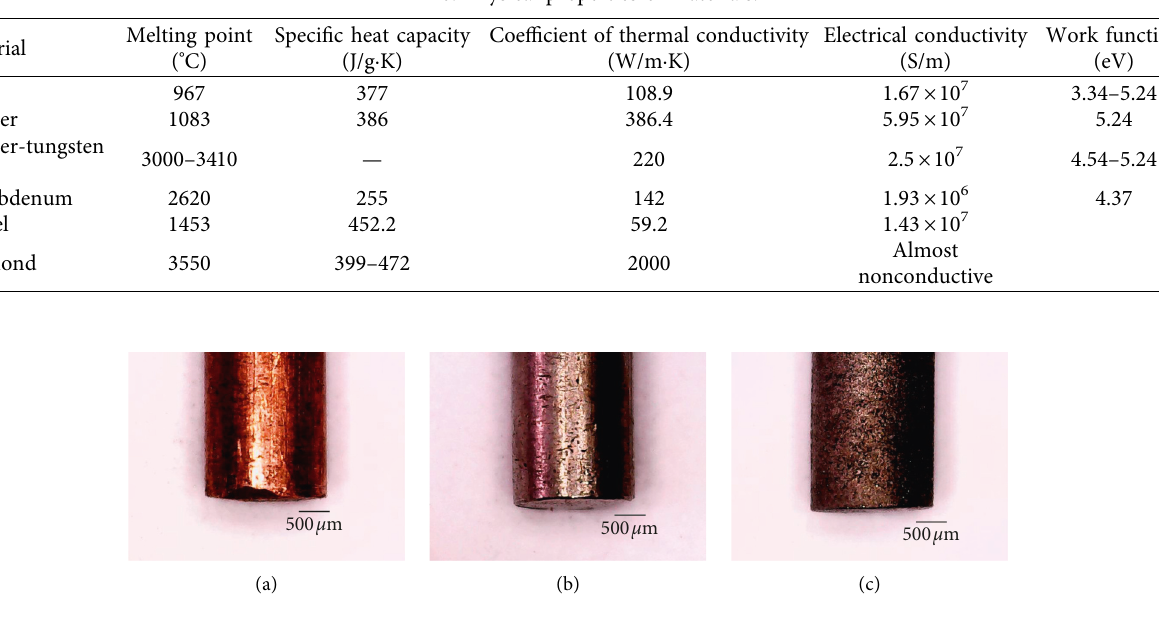
Figure 3: Composite tools. (a) Common copper tool. (b) Nickel-coated tool. (c) Diamond-nickel-coated tool.